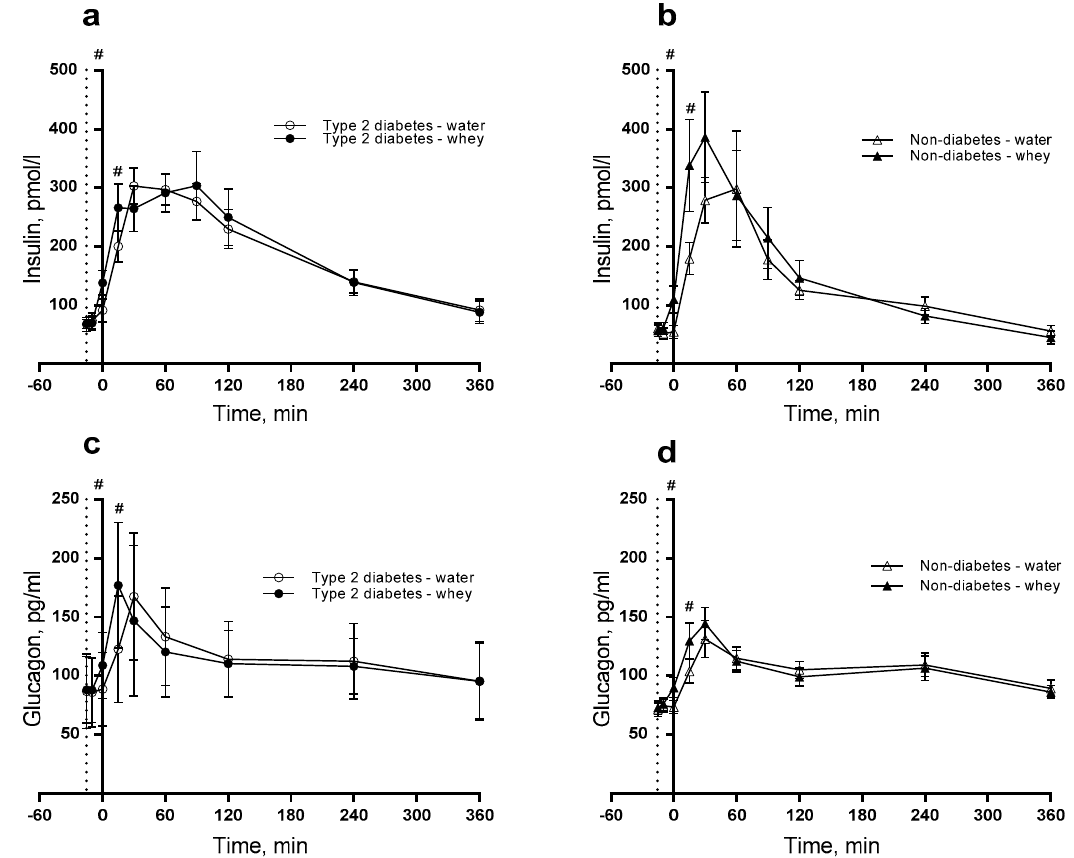
Figure 2. Postprandial responses of insulin ( a , b ) and glucagon ( c , d ). 12 T2D ( a , c ) and 12 non-diabetic subjects ( b , d ) were observed after consumption of 20 g whey proteins (WP) or water taken as a pre-meal 15 min prior to a fat-rich meal. Dotted vertical line (y = − 15) indicates pre-meal consumption. Data are presented as mean ± SEM, n = 24. # indicates differences between pre-meals (WP and water). ANOVA for repeated measurements was used to examine the effect of diabetes, intervention and time on the postprandial responses.